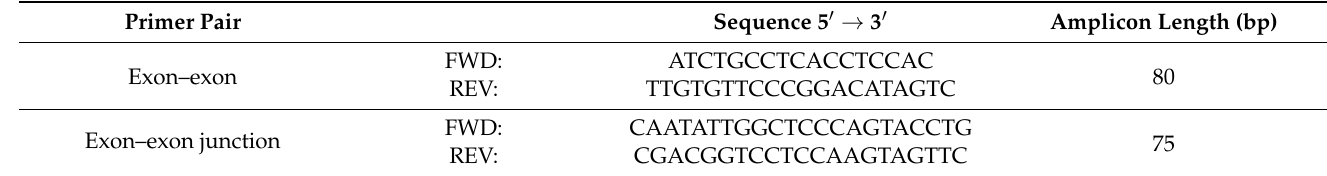
Table 1. Sequences of primers used in PCR. FWD: forward primer, REV: reverse primer, bp: base